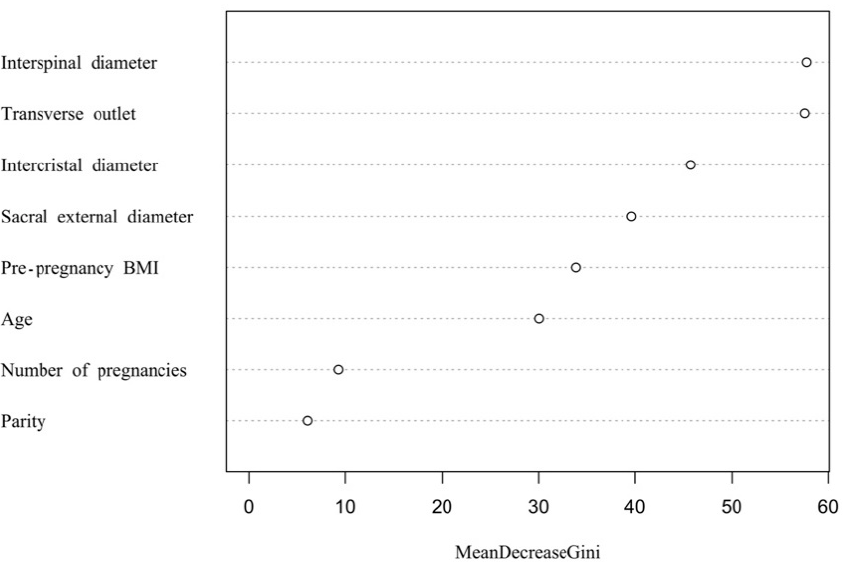
Figure 2. The figure of variable importance ranking in the macrosomia random forest prediction model. Figure 3. The histogram of treesize of the random forest model.